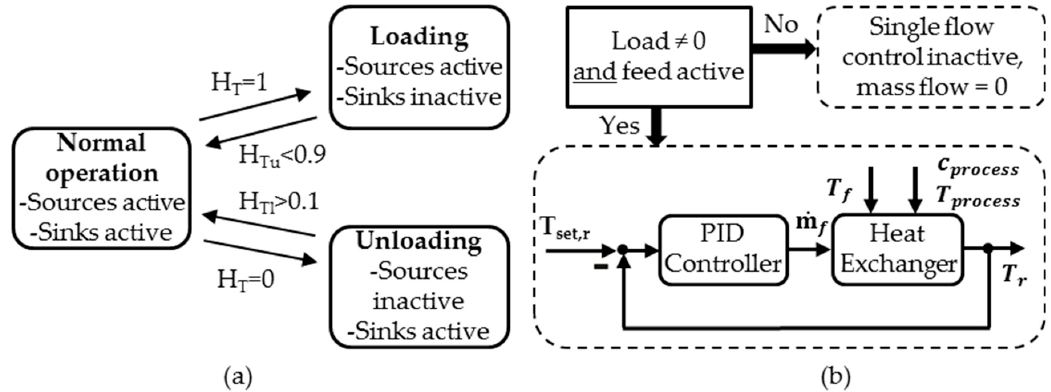
Figure 6. ( a ) System controls depending on the thermocline position and ( b ) single mass flow control adjusting T hot and T cold .